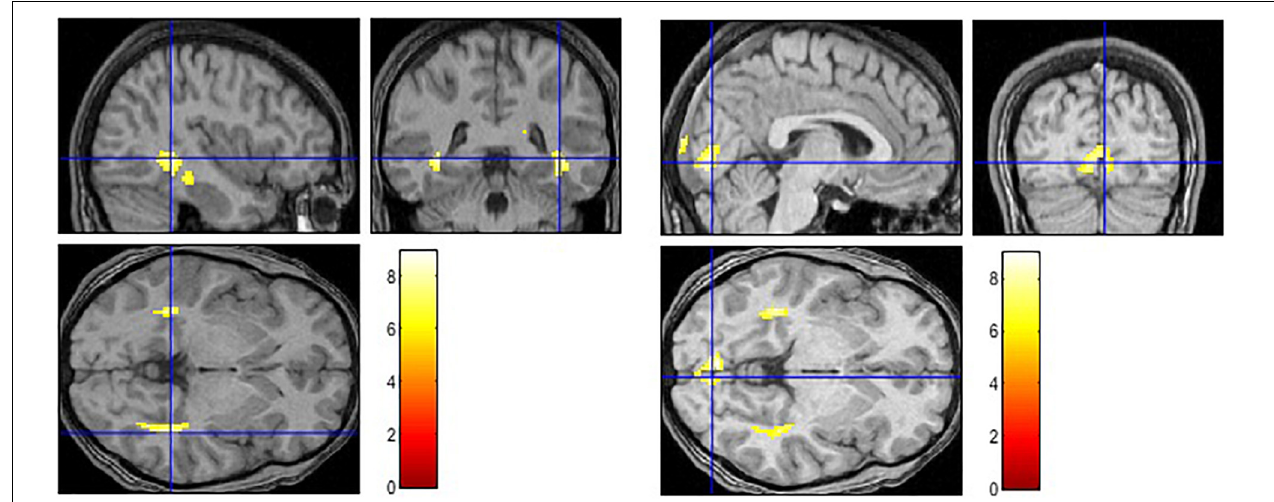
FIGURE 1 | Activation in limbic and paralimbic regions in the negative condition (Negative > Baseline) (left) and in higher-order vision-related regions in the neutral condition (Neutral > Baseline) (right).